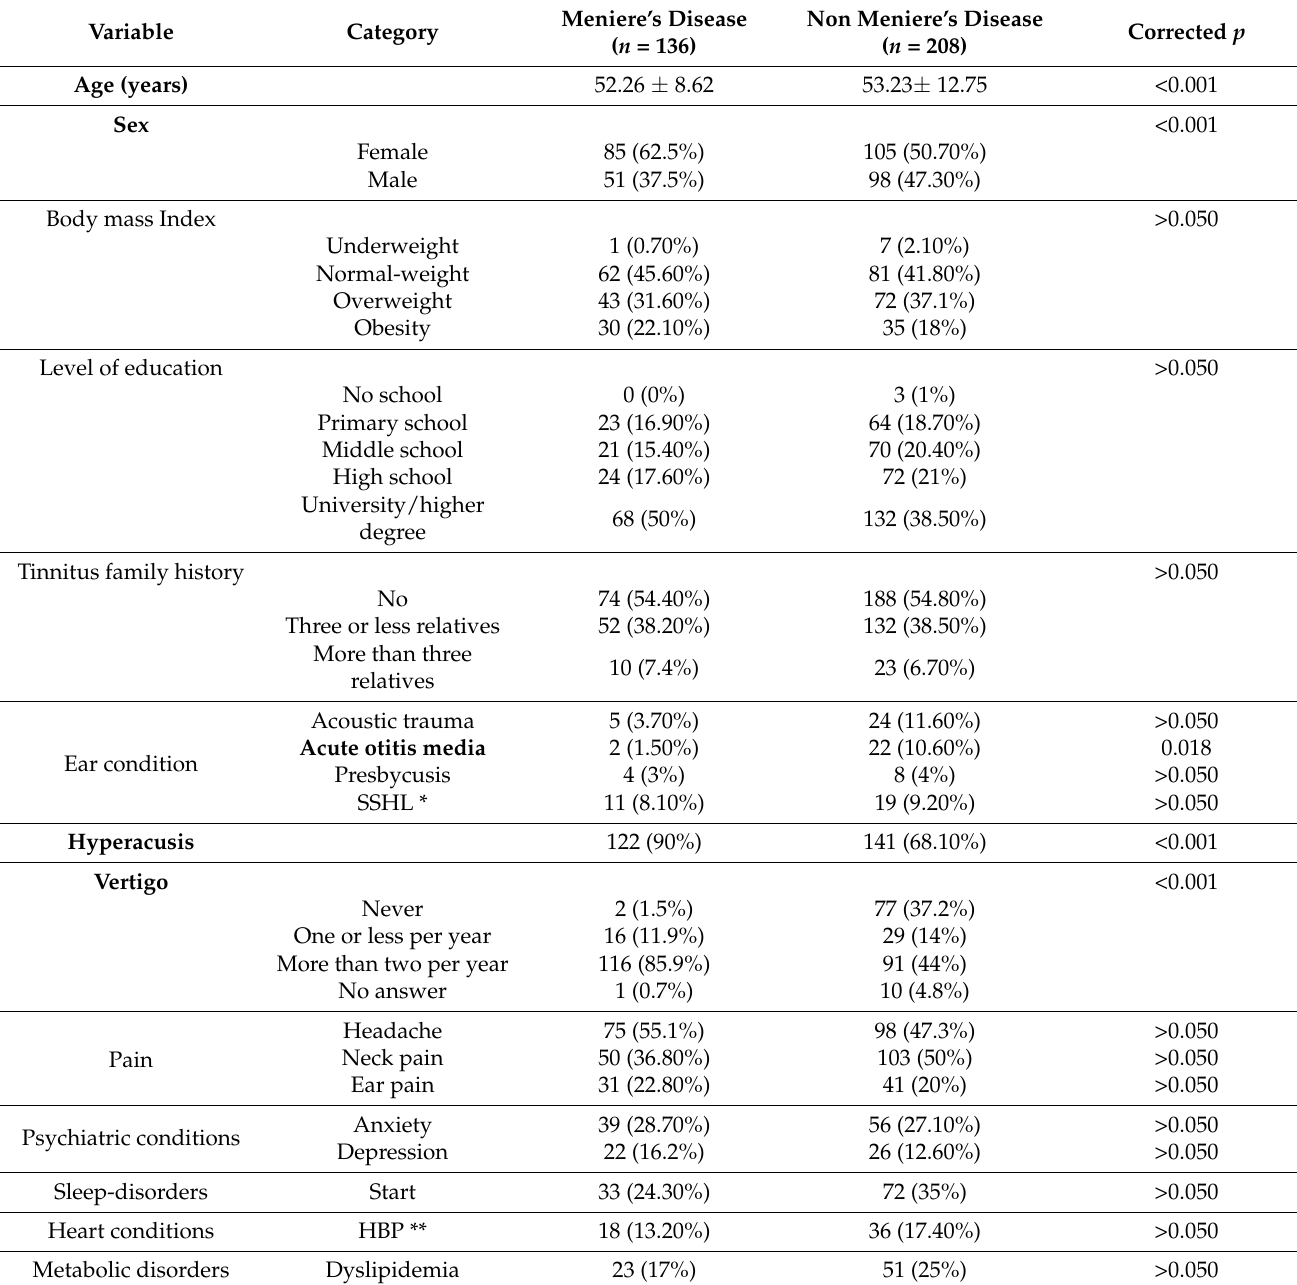
Table 6. Demographic data and comorbid conditions in patients with chronic tinnitus after stratifying for Meniere’s disease ( n =